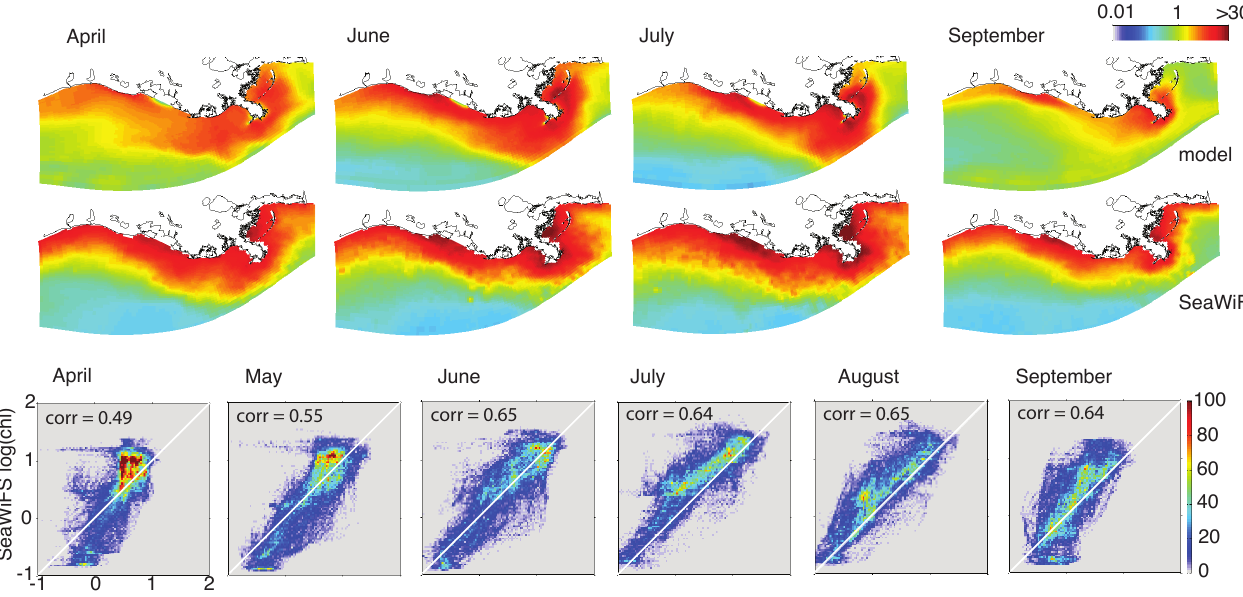
Fig. 6. Monthly climatology of simulated surface chlorophyll for the years 1998 to 2004 (top row) and surface chlorophyll from the SeaWiFS satellite for the same period (row below) for April, June, July and September. 2-dimensional histograms of SeaWiFS over model chlorophyll from April through September and their correlation are shown in the bottom row. The 1-to-1 line is shown in white. Color indicates the number of simulated and observed chlorophyll pairs per bin (see color scale at the bottom